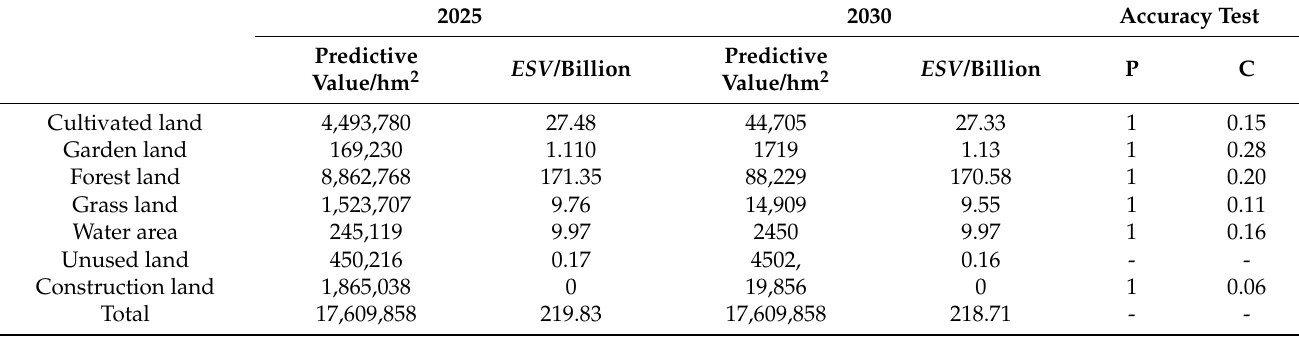
Table 6. Ecosystem services value in Guizhou Province in 2025 and